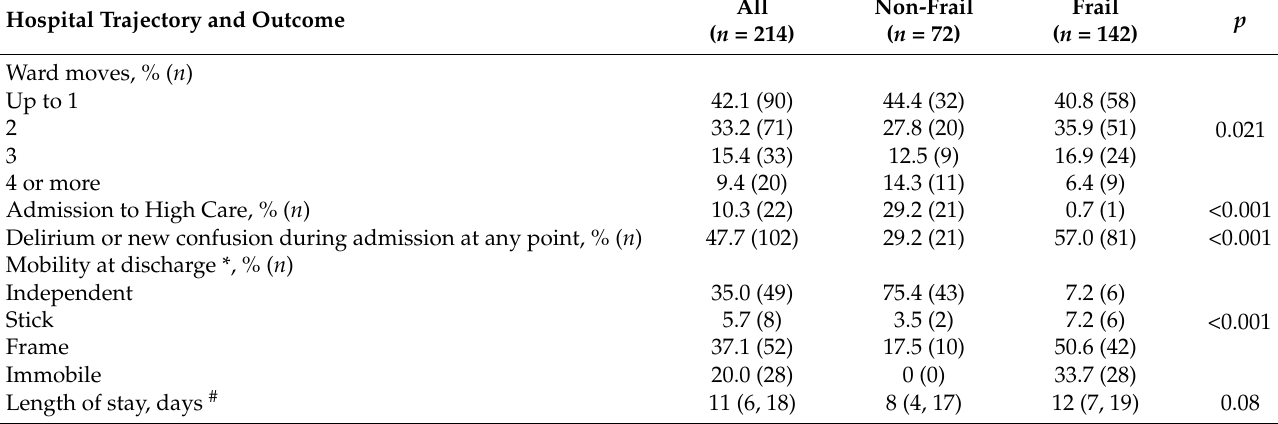
Table 2. Hospital Trajectory and Outcome of the whole cohort and by frailty (CFS 1–4 “Nonfrail” versus CFS 5–8 “Frail”). Hospital Trajectory and